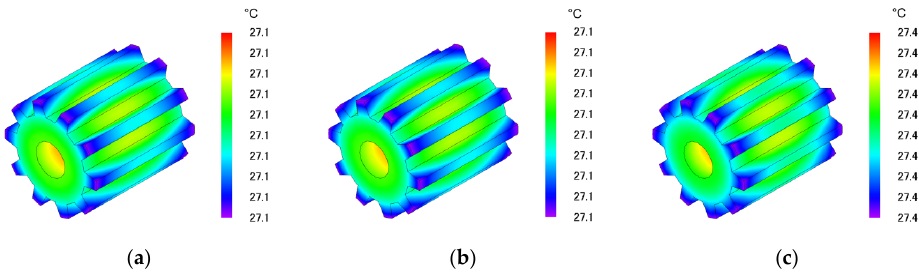
Figure 16. Temperature distributions in rotor, when NdFeB is employed. ( a ) PM-top; ( b ) PM-bottom; ( c ) PM-middle-1&-2.